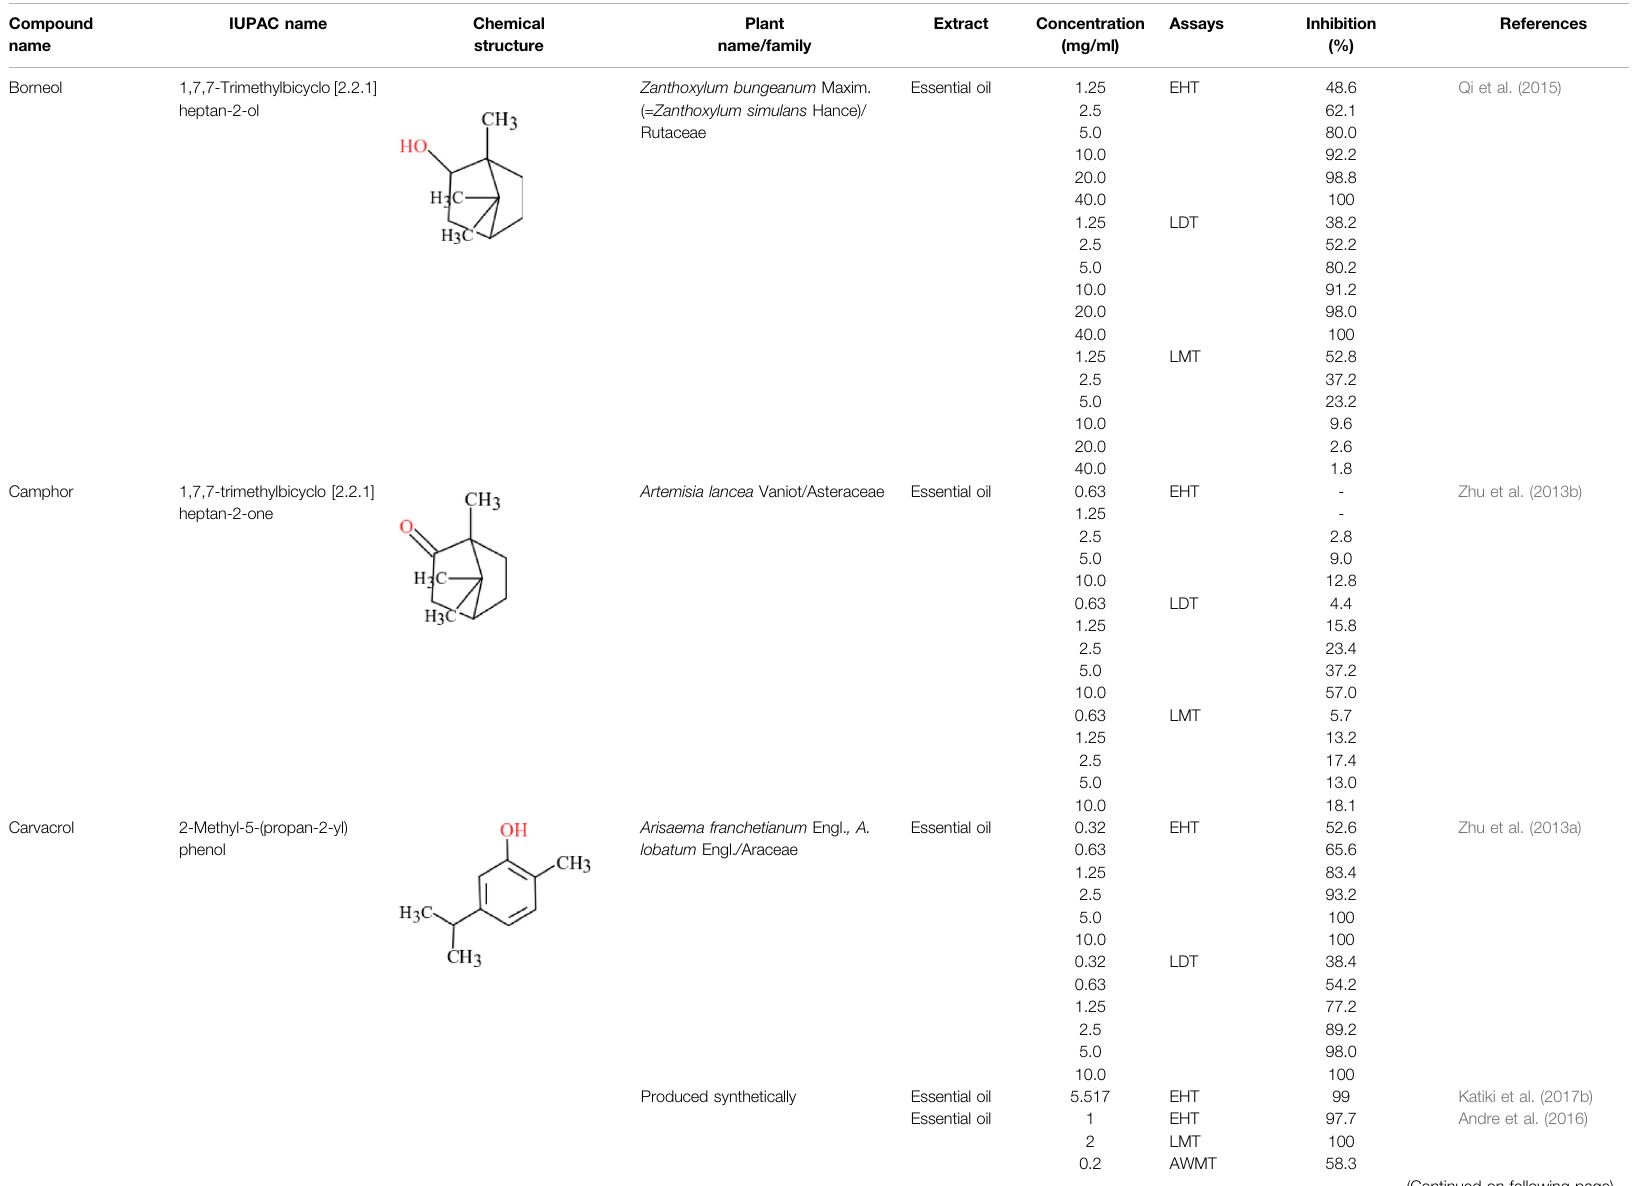
TABLE 3 | ( Continued ) Plant compounds ef fi cacy against H. contortus